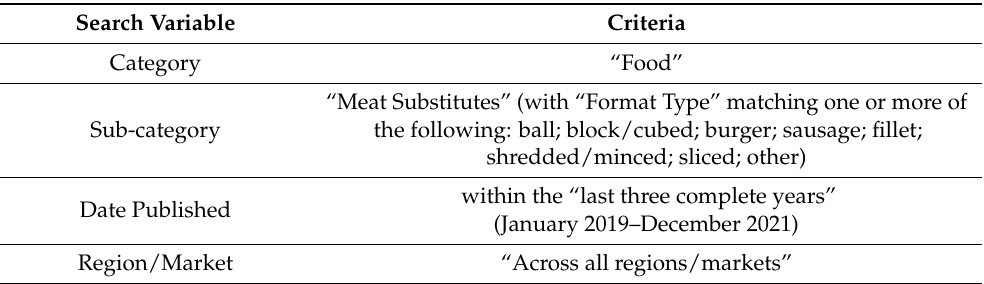
Table A1. Search criteria considered in Mintel